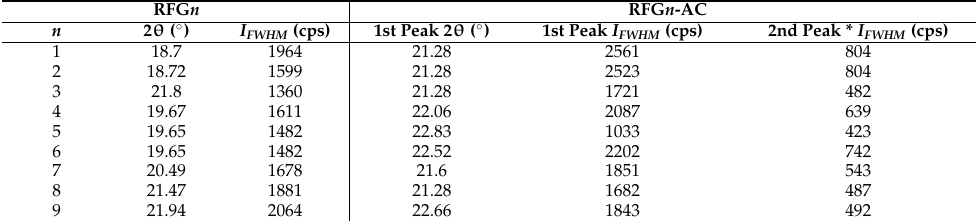
Table 3. XRD peak locations and FWHM intensities of RFGn and RFGn-AC